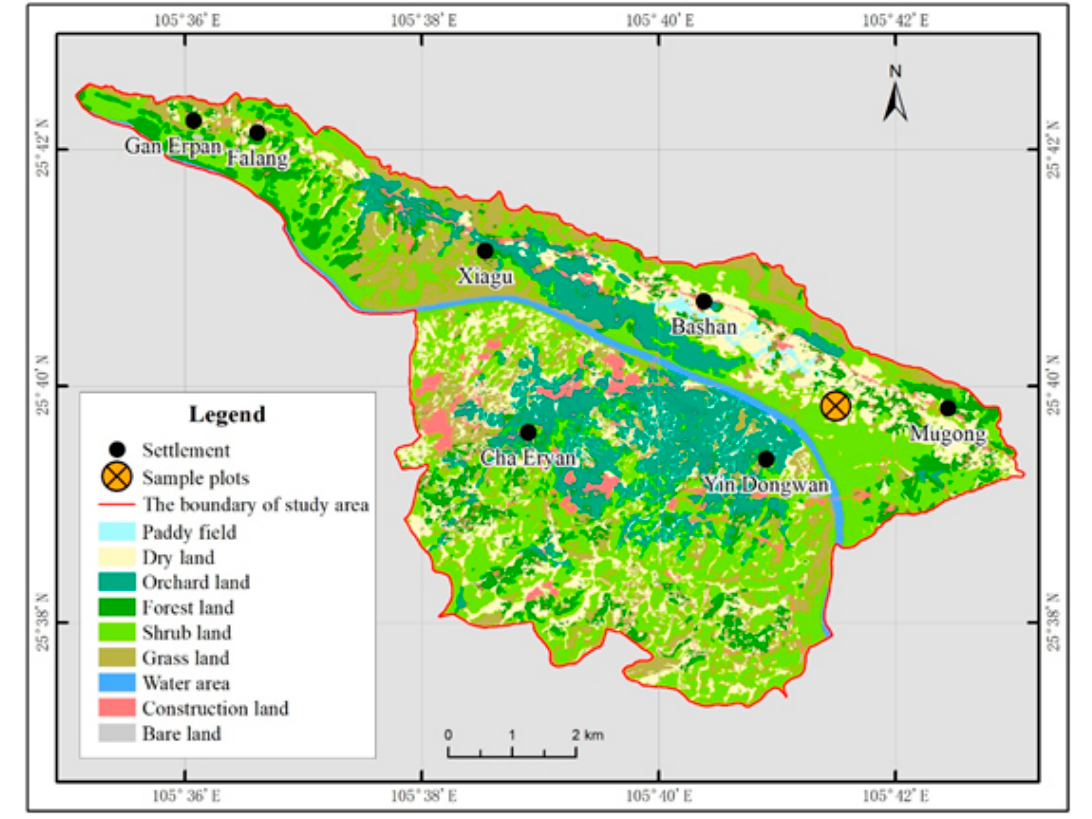
Figure 1. The sample plot distribution map.